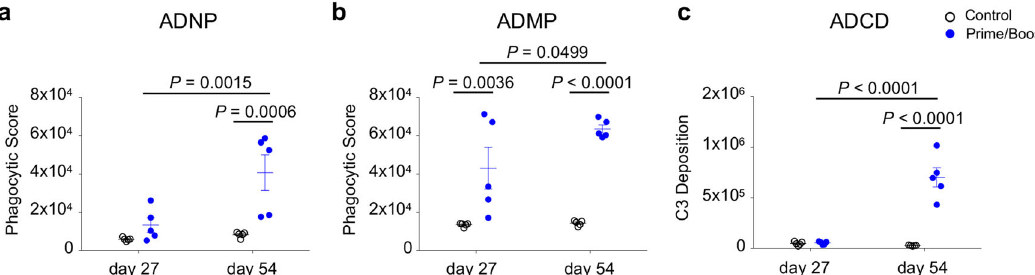
Fig. 5 MVA-VLP-SUDV elicits antibodies capable of inducing multiple Fc-dependent innate immune effector functions. Sera collected at day 27 (after the fi rst vaccine dose) and at day 54 (after the second vaccine dose) were assessed for Fc-dependent antibody functions when stimulated with SUDV GP protein. Guinea pig sera were incubated with GP coated fl uorescent beads which were then incubated with either human neutrophils a or THP-1 monocytes b . Cells were then analyzed by fl ow cytometry to quantify phagocytic intake of fl uorescent bead/ antibody complexes. GP bound beads were incubated with guinea pig sera and exposed to guinea pig complement c ; and C3 deposition (MFI of FITC) was measured by fl ow cytometry using a fl uorescent anti-guinea pig C3 antibody. Mean values ± SEM. N = 5 animals per group. P values determined by 2-way ANOVA followed by Sidak ’ s multiple comparison test. N = 5 animals per group. ADNP, antibody-dependent neutrophil phagocytosis; ADMP, antibody-dependent monocyte phagocytosis; ADCD, antibody-dependent complement